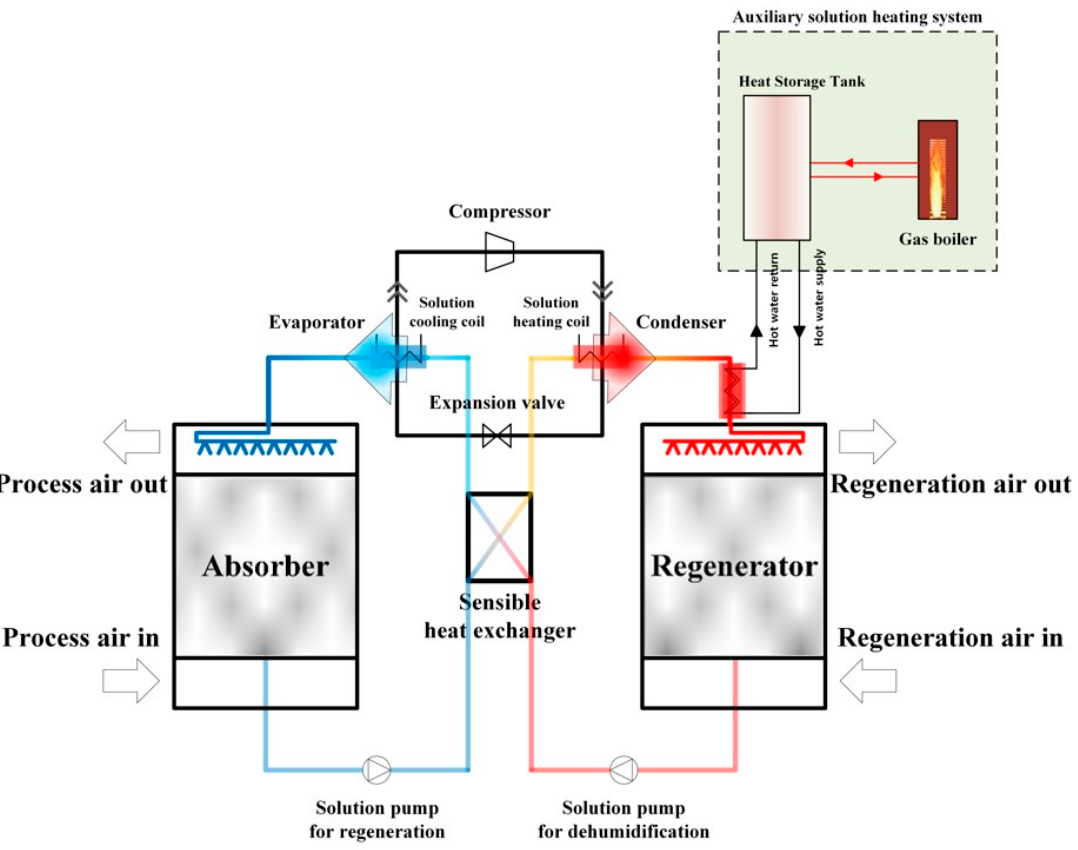
Figure 4. Schematic diagram of the heat pump driven liquid desiccant (HPLD) system.